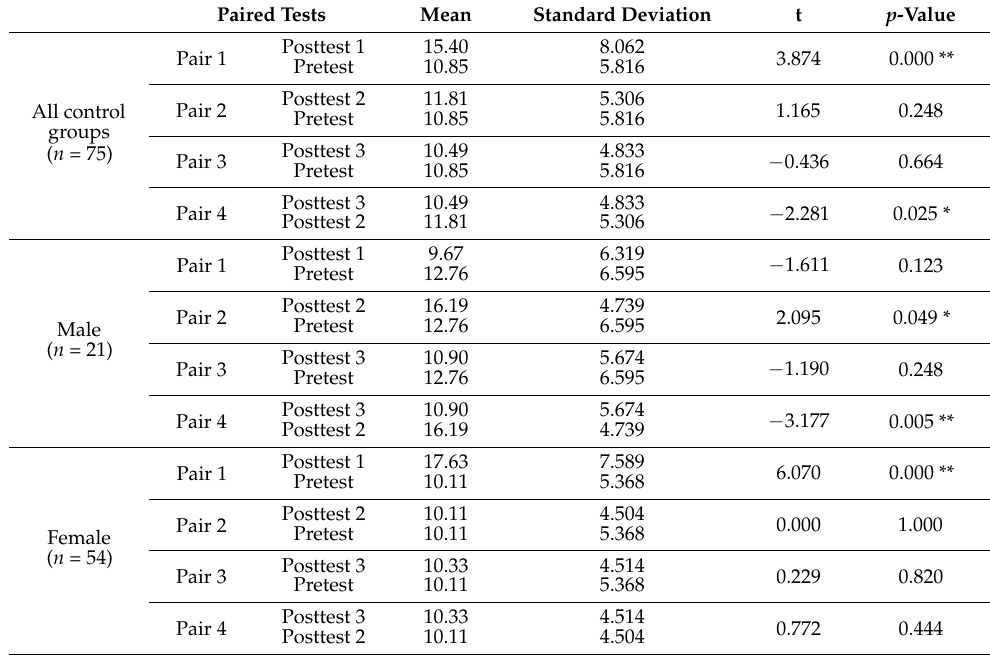
Table 3. Paired Samples t-test Results of the Differences between Paired Tests within the Control Groups.